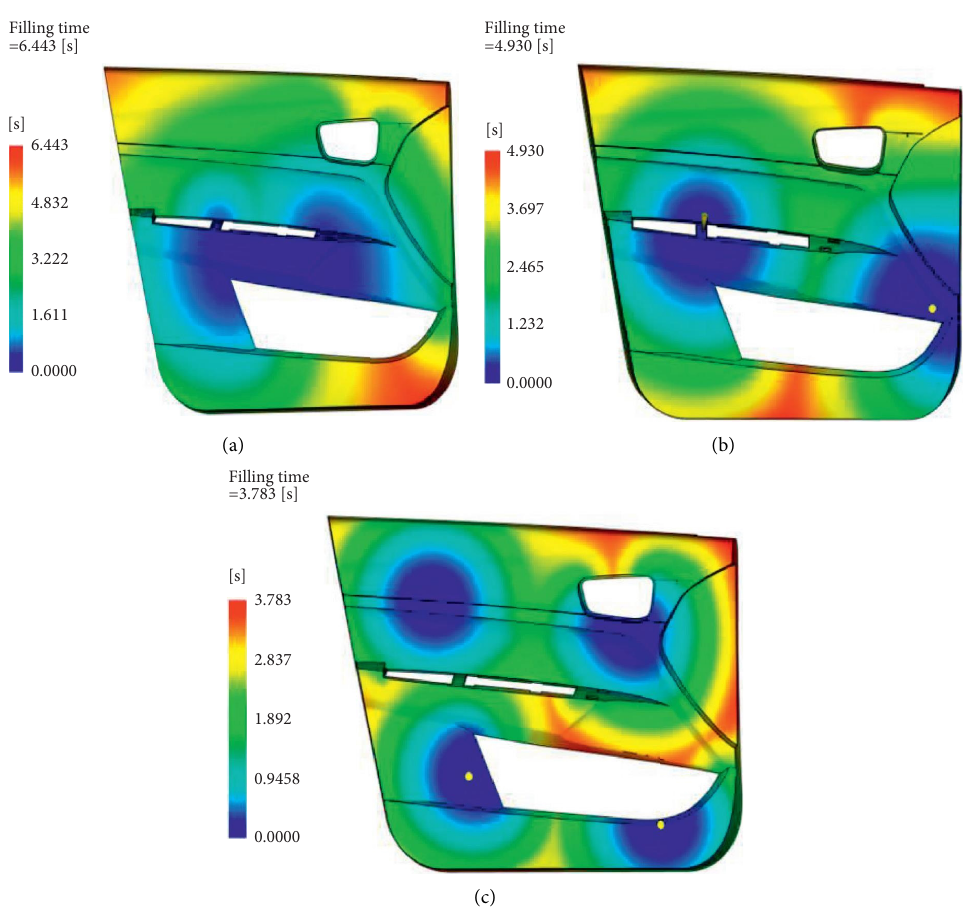
Figure 6: Filling time of three gate location schemes. (a) Single gate. (b) Two gates. (c) Four